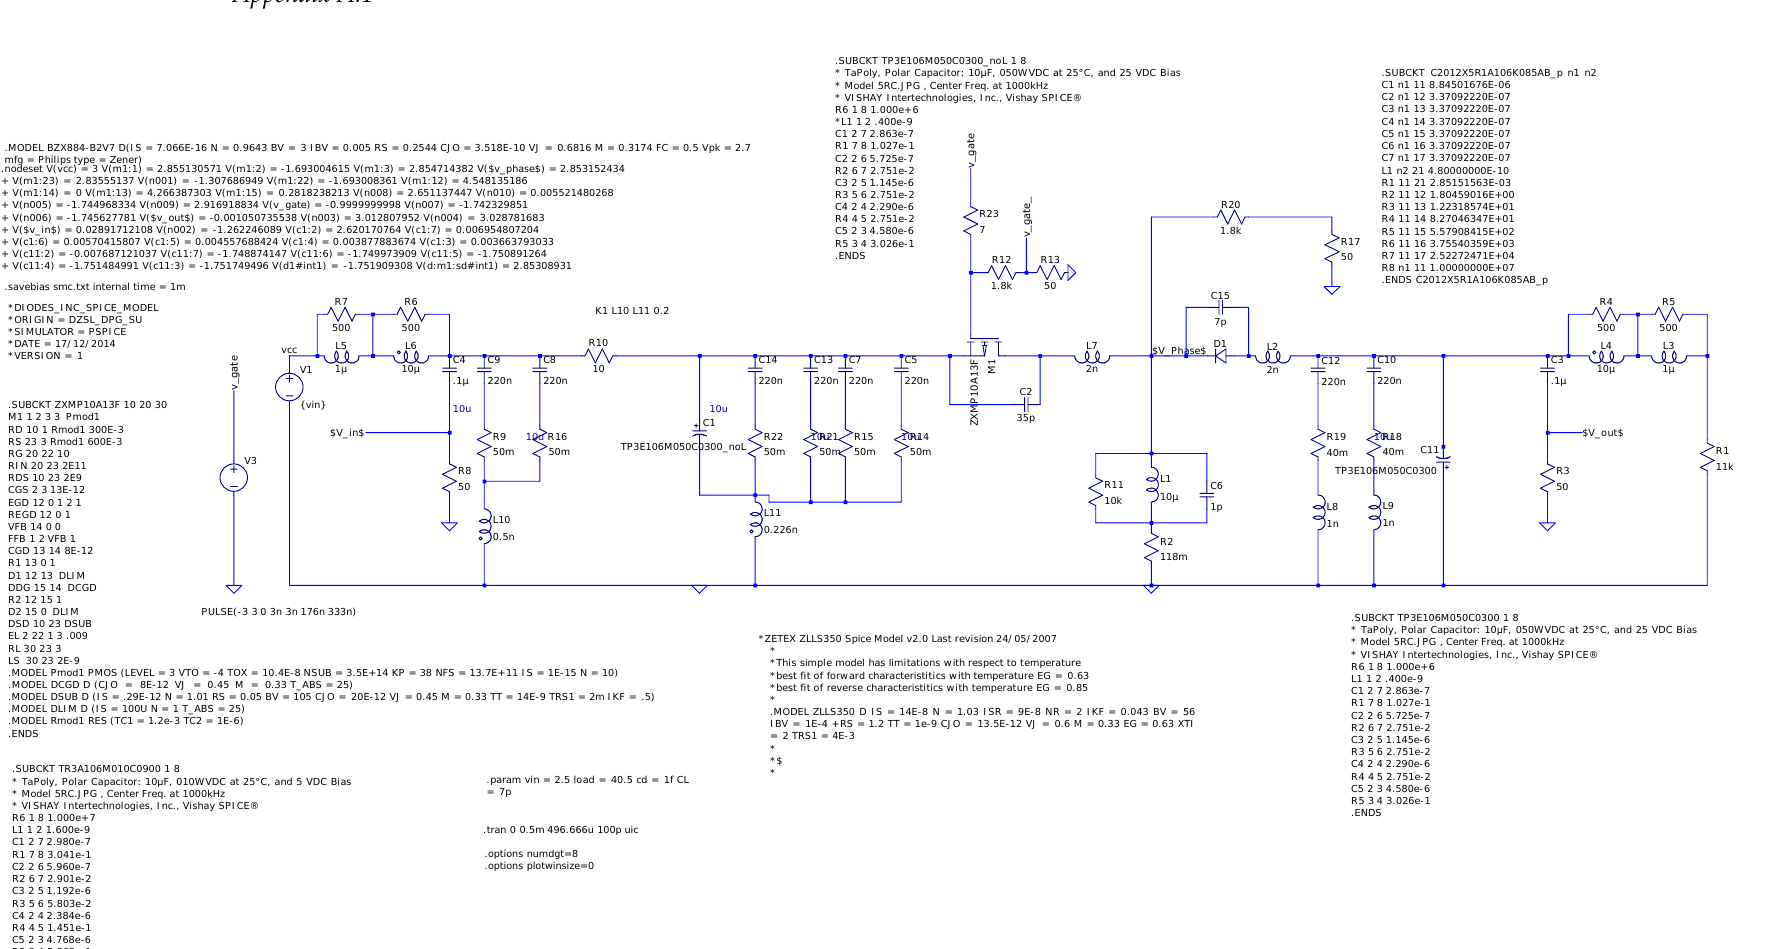
Figure A1. Used spice model to generate simulation results of the converter built with discrete